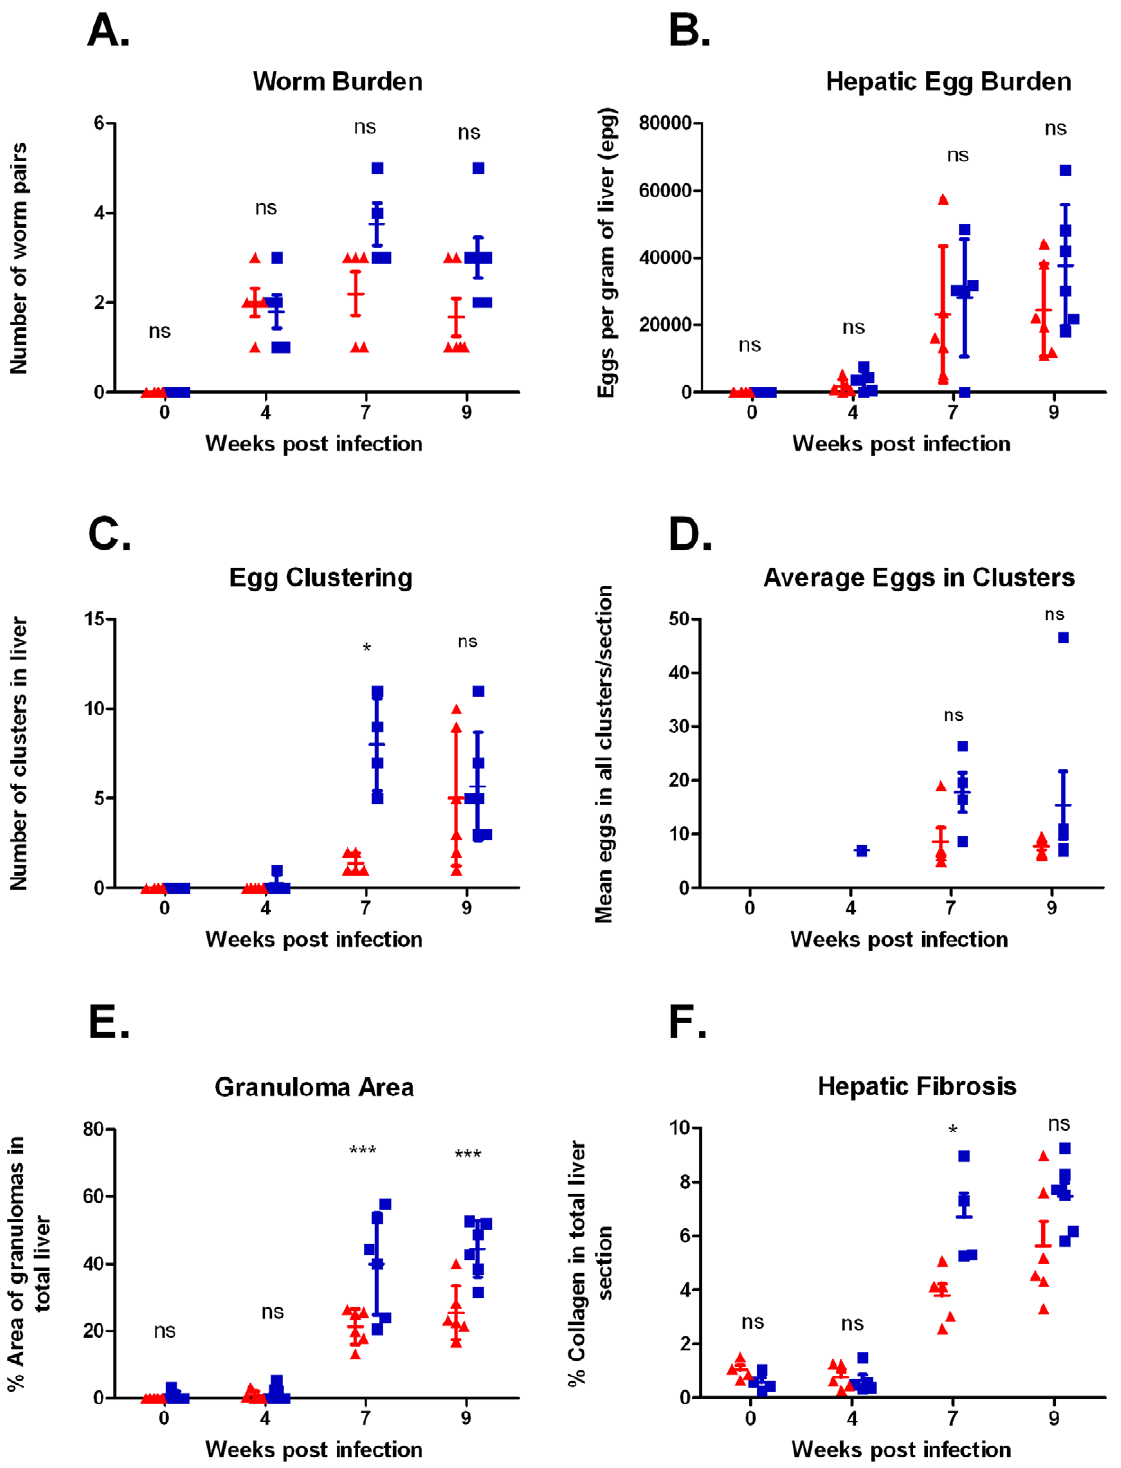
Figure 1. Parasitological and histological comparisons between BALB/c and CBA mice. Worm abundance ( A ) and hepatic egg burden ( B ) did not differ significantly between strains; egg clustering ( C ) was significantly greater in CBA mice compared to BALB/c mice at 7 weeks p.i, yet the mean number of eggs per cluster ( D ) did not differ significantly between strains. Granuloma area ( E ) was significantly greater in CBA mice compared to BALB/c mice, as was hepatic fibrosis at 7 weeks p.i ( F ). Statistical significance between strains was determined using 2-Way ANOVA with Bonferroni post hoc tests. m =BALB/c replicates, & =CBA replicates, ***=p , 0.001, *=p , 0.05, ns=no significant difference. Error bars represent mean with standard error of the mean (SEM).